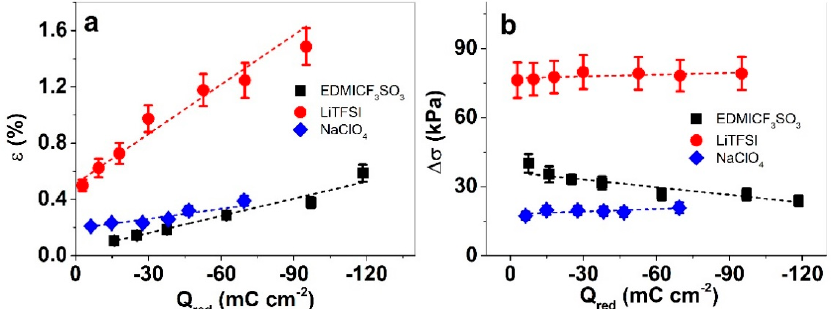
Figure 4. Square wave potential steps (1.0 V to − 0.6 V) response of PP–IPN trilayer in EDMICF 3 SO 3 ( ■ , black), LiTFSI ( ● , red) and NaClO 4 ( ♦ , blue) in propylene carbonate. The charge densities at reduction (Figure S3b) were obtained at di ff erent applied frequencies by integrating the current density / time curves (Figure S3a, 0.005 Hz). The strain and stress di ff erences against the charge density are shown in ( a , b ), respectively. The dashed lines are the linear fits, shown for